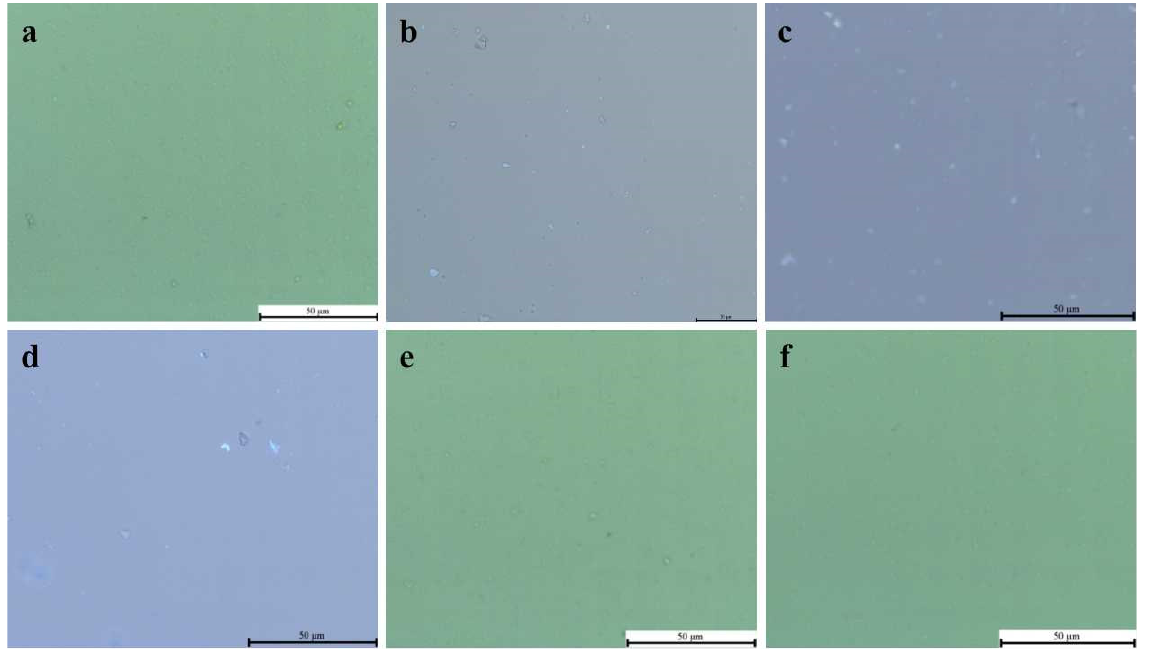
Figure 7. Diagnostic molecular targeted Agrobacterium tumefaciens fluorescence assay: ( a ) fluorescence detection of Agrobacterium tumefaciens without inhibitor and probe; ( b ) agrobacterium fluoresce was detected by adding inhibitor A1 and probe T4; ( c ) fluorescence detection of Agrobacterium with inhibitor A2 and probe T4; ( d ) agrobacterium fluorescence detection with inhibitor A3 and probe T3; ( e ) only Agrobacterium tumefacien probe T4 was added for fluorescence detection; ( f ) only Agrobacterium tumefacien probe T3 was added for fluorescence detection.